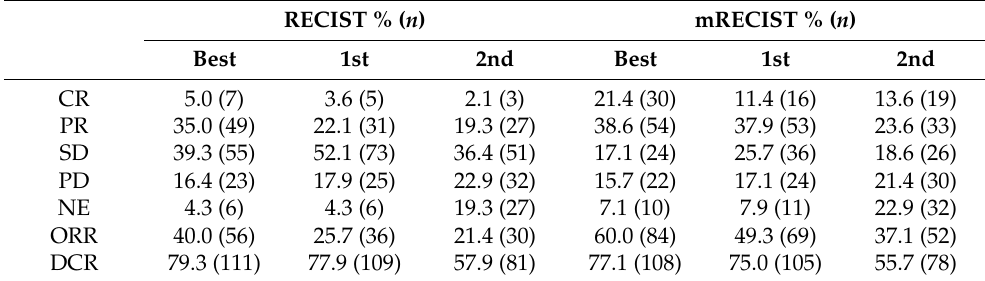
Table 2. Radiological response to